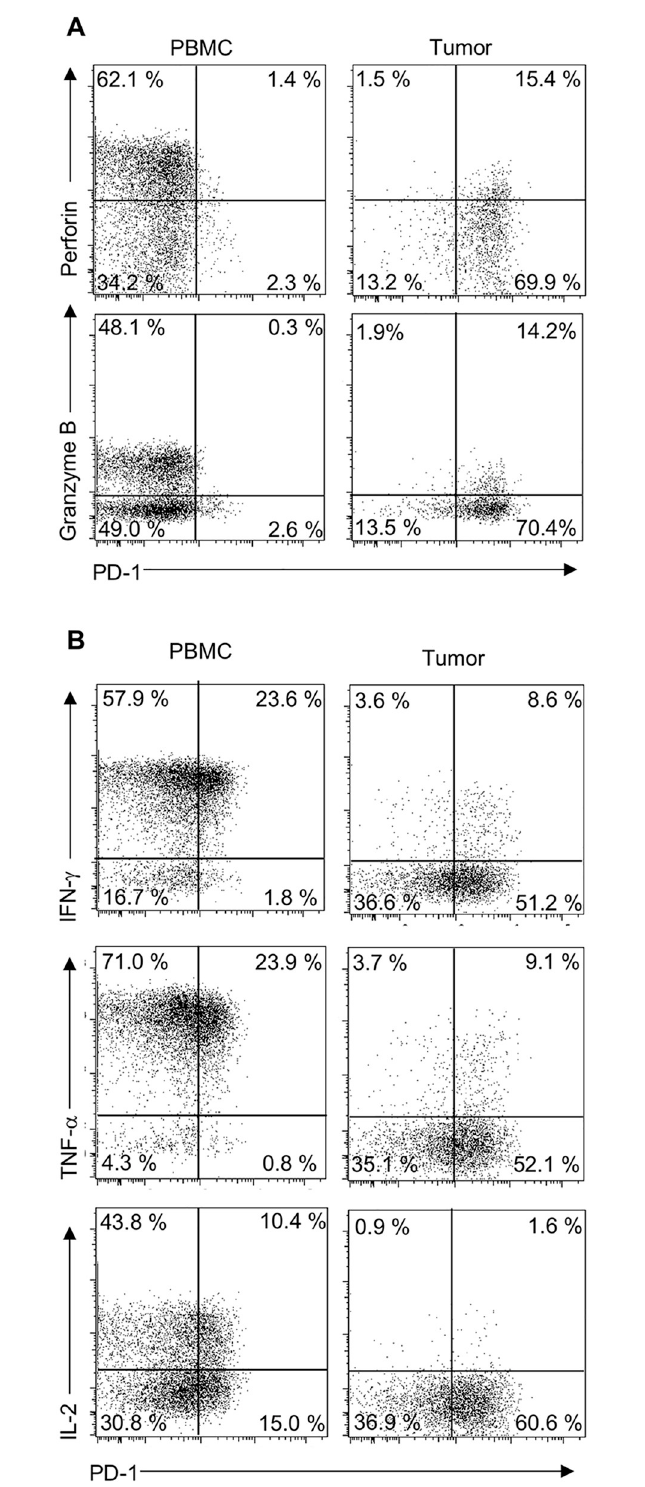
Fig 3. Flow cytometric analysis of PD-1 expression and the production of perforin, granzyme B, IFN-g, TNF-a, and IL-2 in CD8+ T cells in PBMCs and tumor tissues from EMPD patients. Freshly isolated PBMCs and digested tumor tissues were analyzed by flow cytometry. Flow cytometric plots were pregated on TCRab+CD8+ cells, excluding dead cells and na ï ve T cells (CD45RA+CCR7+ T cells). (A) Representative flow cytometric plots of PD-1 expression and perforin and granzyme B intracellular staining among CD8+ T cells are shown. (B) Representative flow cytometric plots of PD-1 expression and IFN-g, TNF-a, and IL-2 intracellular staining among CD8+ T cells are shown.